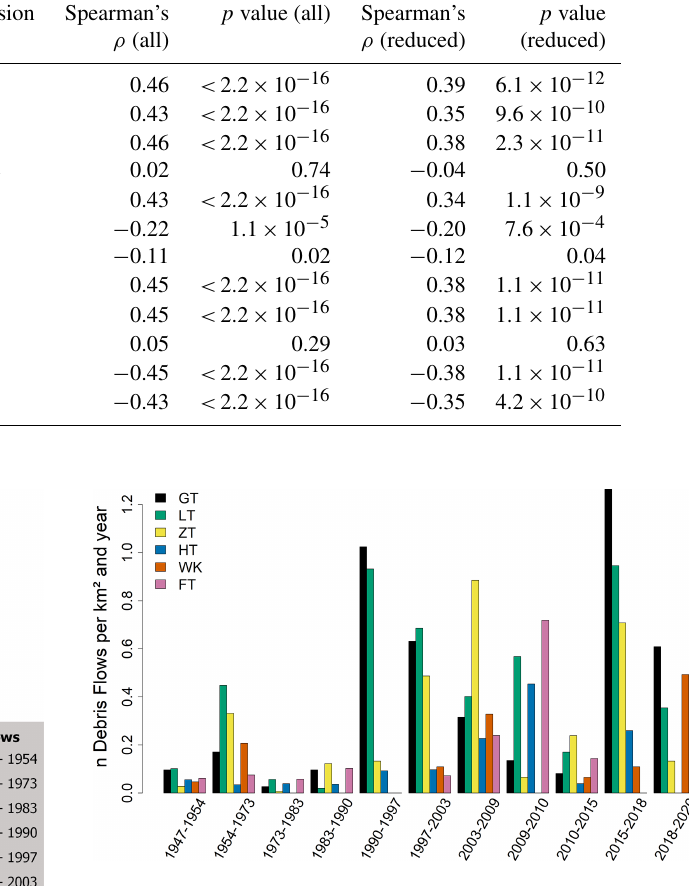
Figure 5. Mapped debris flows per square kilometre and year. Dis- tinguished between time intervals and